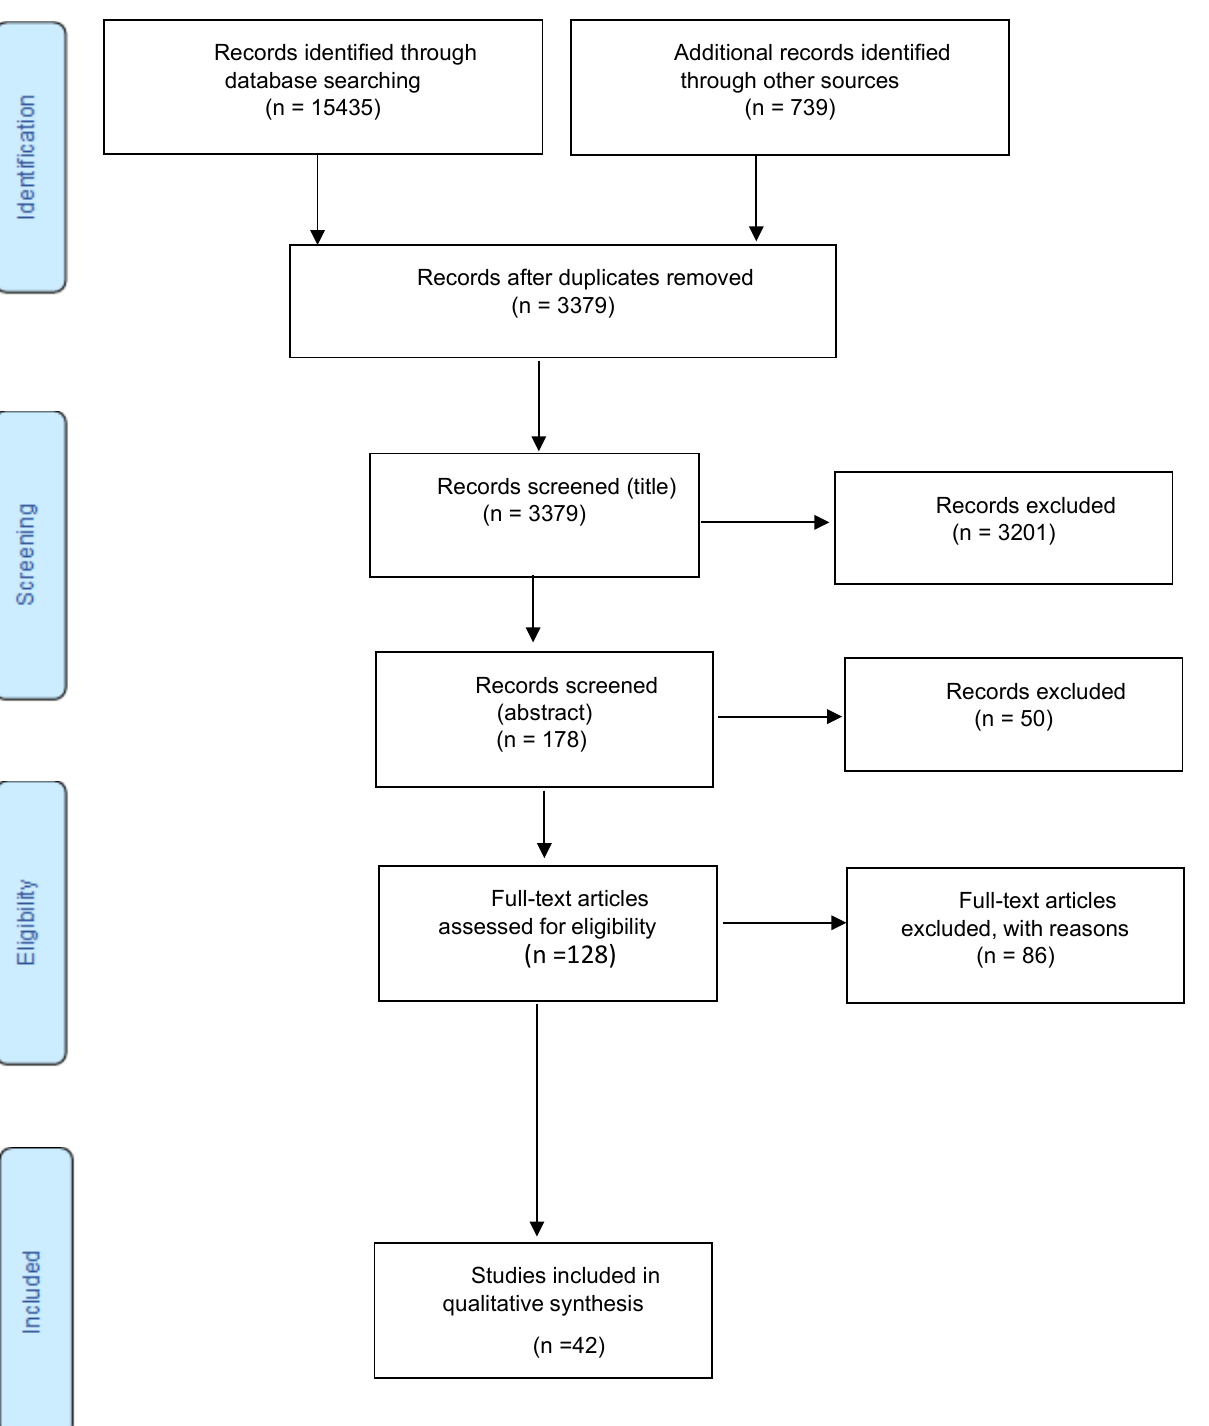
Figure 1 The PRISMA Flow Diagram Describing the Process of Study